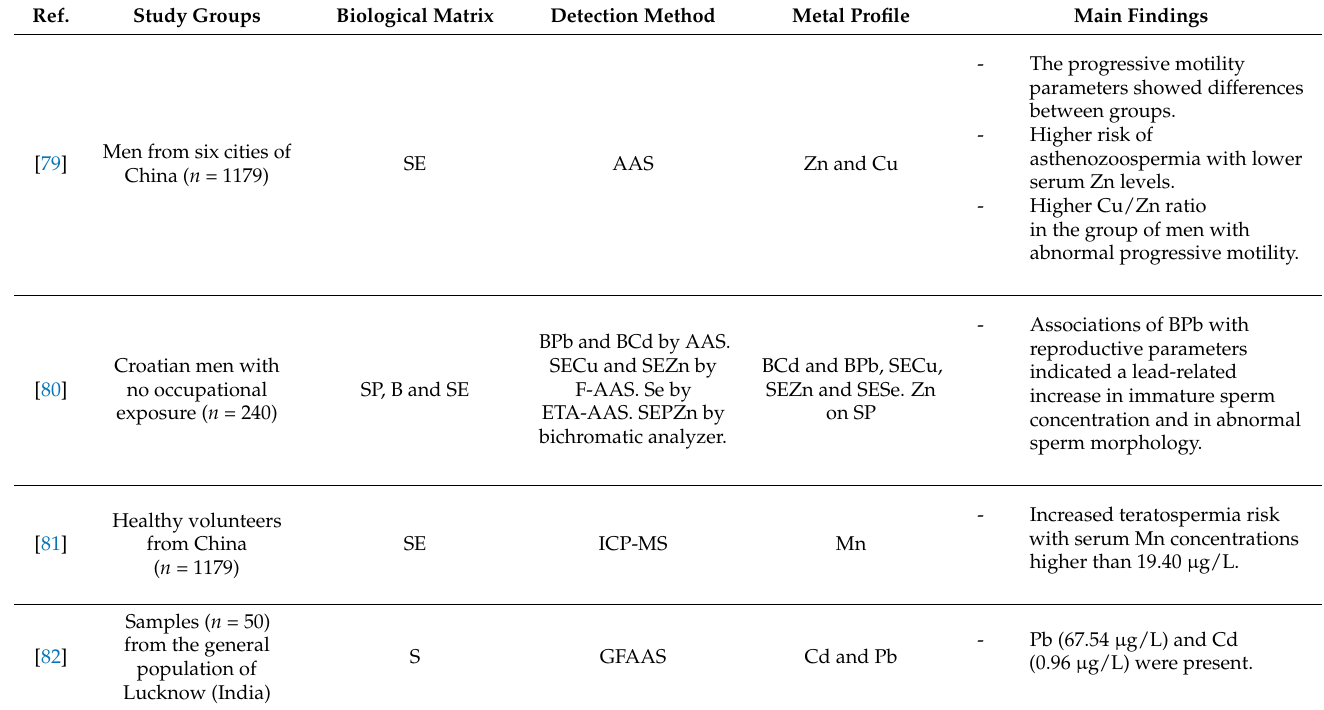
Table 3. Articles studying the relationship between heavy metals and reproductive parameters in study subjects from general